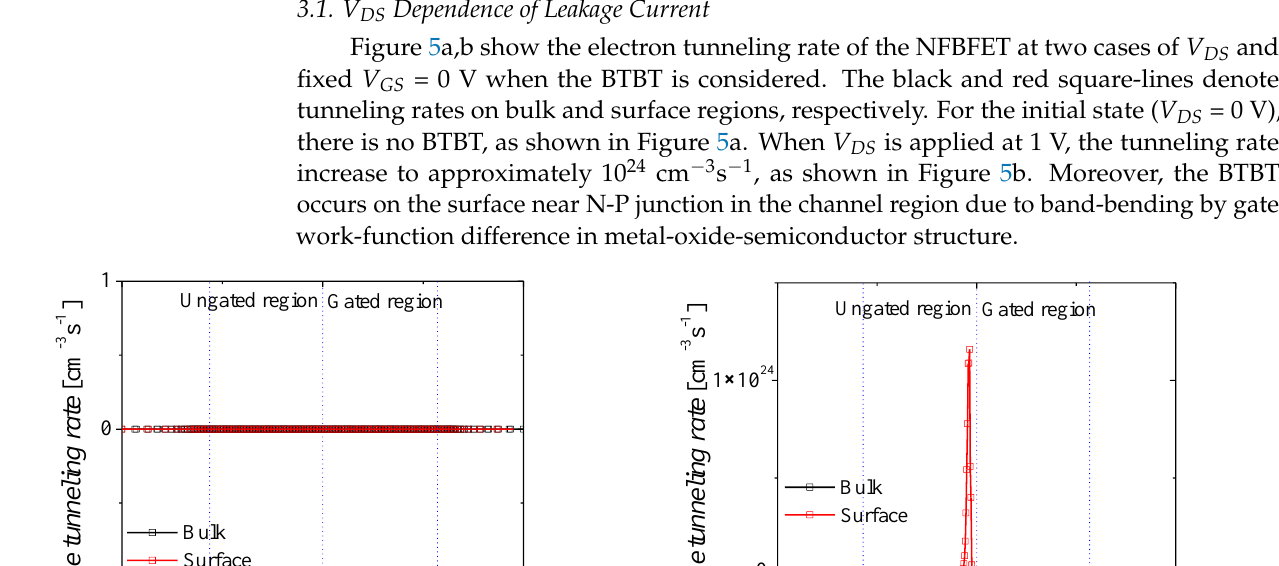
Figure 4. Comparison of I DS - V GS characteristics of NFBFET between considering and ignoring the BTBT at V DS = 1 V.